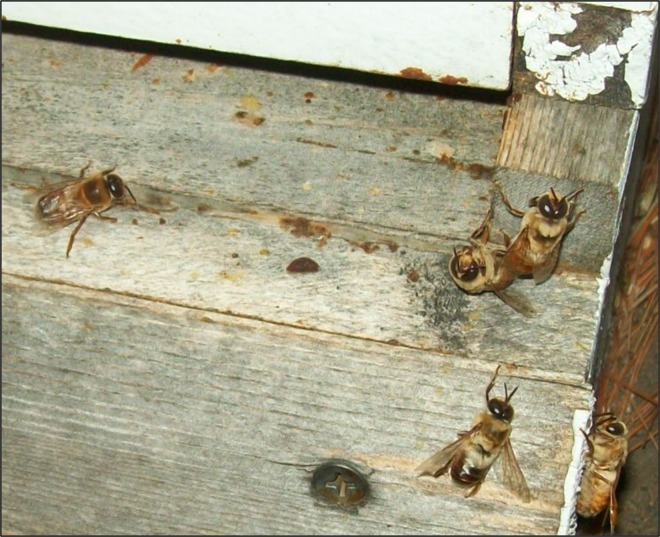
Drone honey bees showing symptoms of Ss1 infection.Drone honey bees that were unable to fly could be found attached to the hive near the entrance or crawling on the ground in front of the hive. Bacterial culture of the hemolymph from these drones revealed Ss1 in high concentration (9.5 x 10e9 +/-1.9 x 10e9 cfu/ml, n = 16). Unlike SIW, these SID were observed intermittently during warm seasons (>16°C).